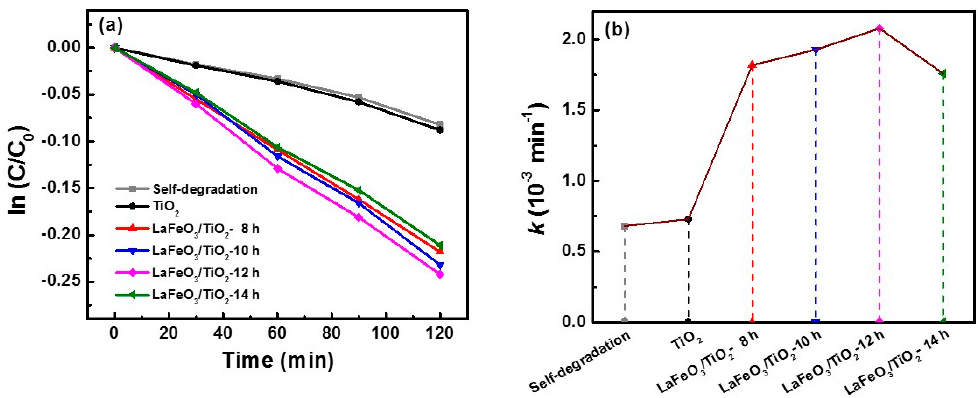
Figure 6. ( a ) Photodegradation rate of MB for TiO 2 nanotube arrays and LaFeO 3 /TiO 2 nanotube arrays prepared with different hydrothermal reaction times; ( b ) The reaction constant k of each sample.